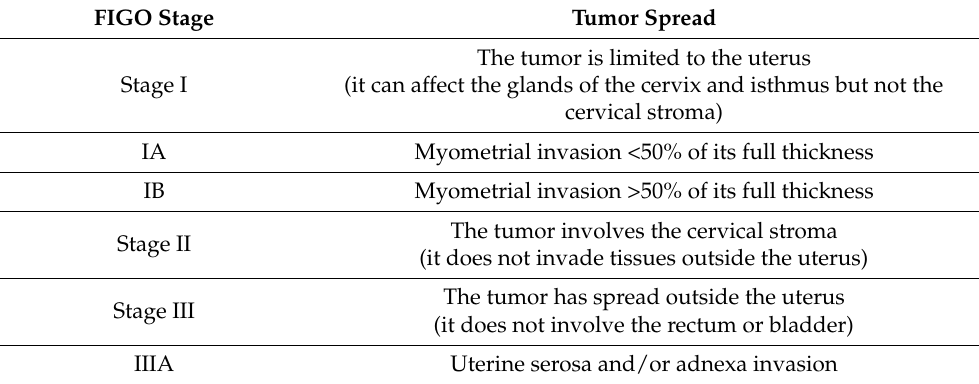
Table 1. Endometrial cancer FIGO staging system. FIGO